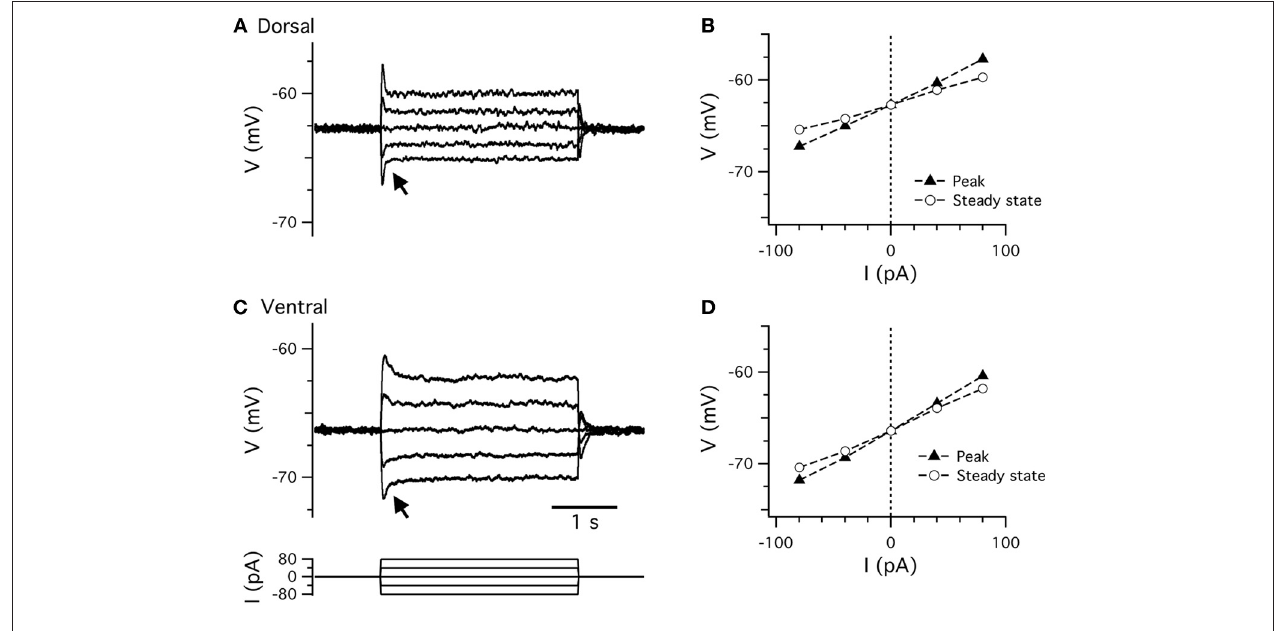
FIGURE 2 | Resting membrane properties. (A,C) Examples of perforated patch-clamp recordings of membrane potential responses to current steps ( C , lower) recorded from dorsal (A) and ventral (C) stellate cells. Arrows indicate the membrane potential “sag.”